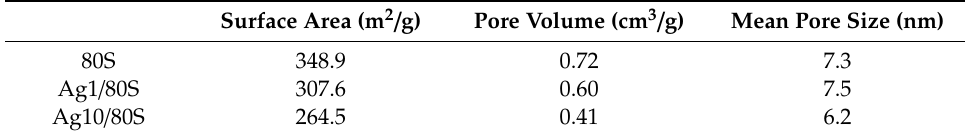
Table 1. Brunauer–Emmett–Teller (BET) equation results of Ag / 80S for di ff erent